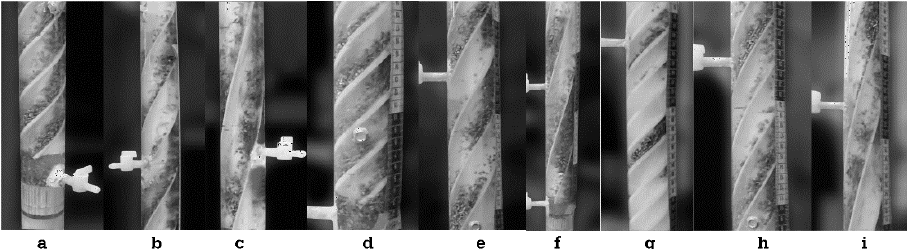
Figure 8. Examples of the quality of fluidization under inclinations of 45 ◦ , 60 ◦ and 75 ◦ and a series of hydraulic diameters achieved by using three, four and five starts for the baffles as follows: ( a ) 45 ◦ , three starts, ( b ) 60 ◦ , three starts, ( c ) 75 ◦ , three starts, ( d ) 45 ◦ , four starts, ( e ) 60 ◦ four starts, ( f ) 75 ◦ , four starts, ( g ) 45 ◦ , five starts, ( h ) 60 ◦ , five starts and ( i ) 75 ◦ , five starts. Table 2. Maximum axial and tangential velocities in tested configurations as modelled in